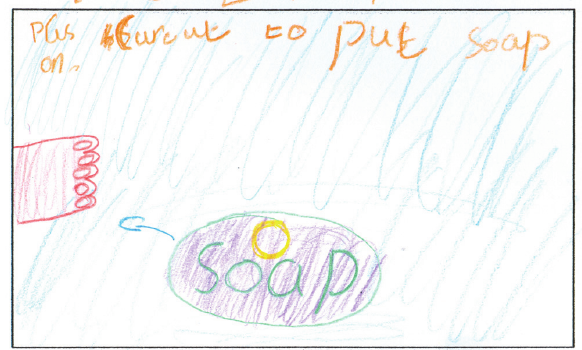
Figure 3. Child drawing of soap being